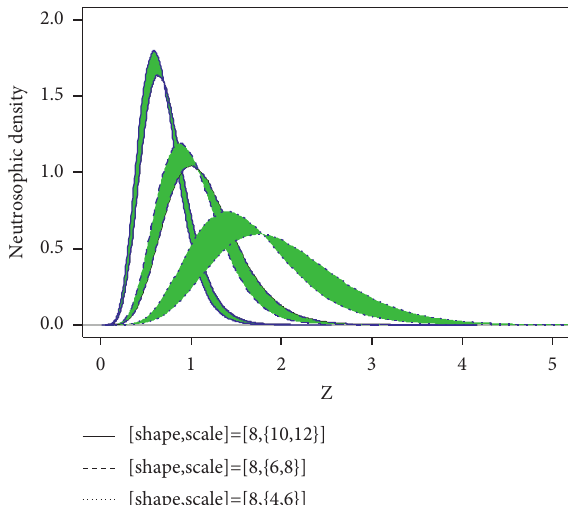
Figure 1: The density of the NGD with the neutrosophic scale parameter.